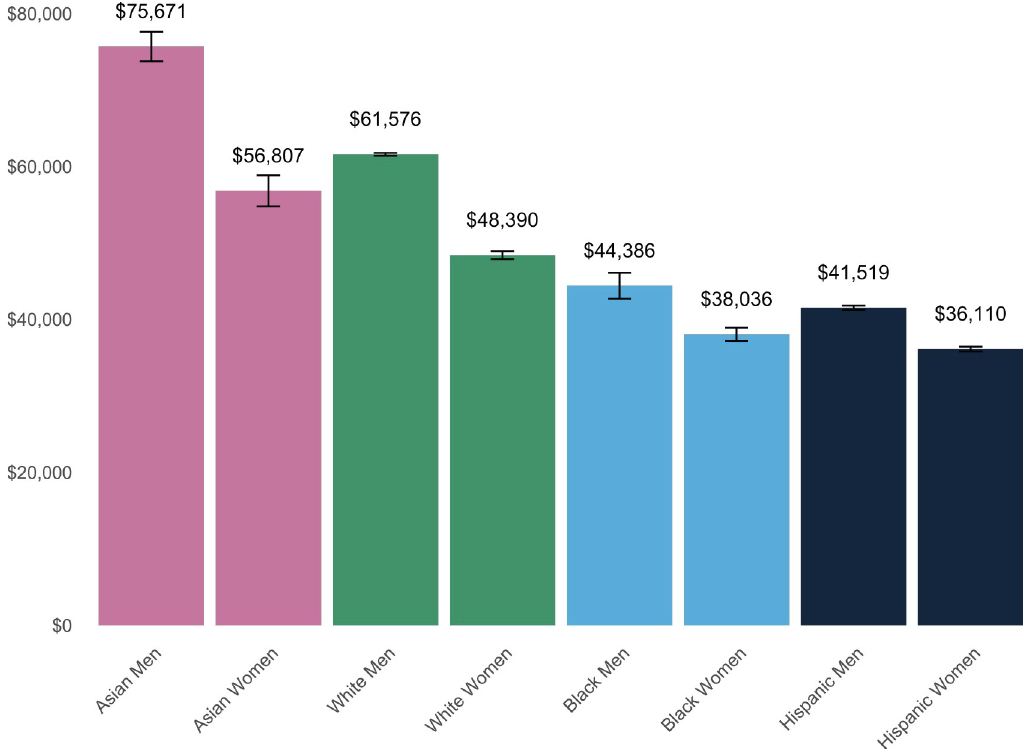
Fig 3. Median annual earnings by race and gender. The Asian, white, and Black categories only include individuals who are not multiracial or of Hispanic ethnicity. The Hispanic category includes individuals of any race with Hispanic ethnicity; thus, some individuals are double counted in 2 categories. Data include individuals over age 15 who were employed full-time for at least 50 weeks of the year. Error bars represent the standard error of the median [142].